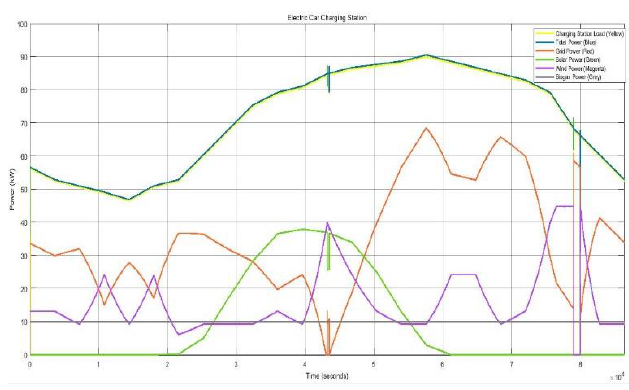
Fig. 8. Renewable energy resources added.